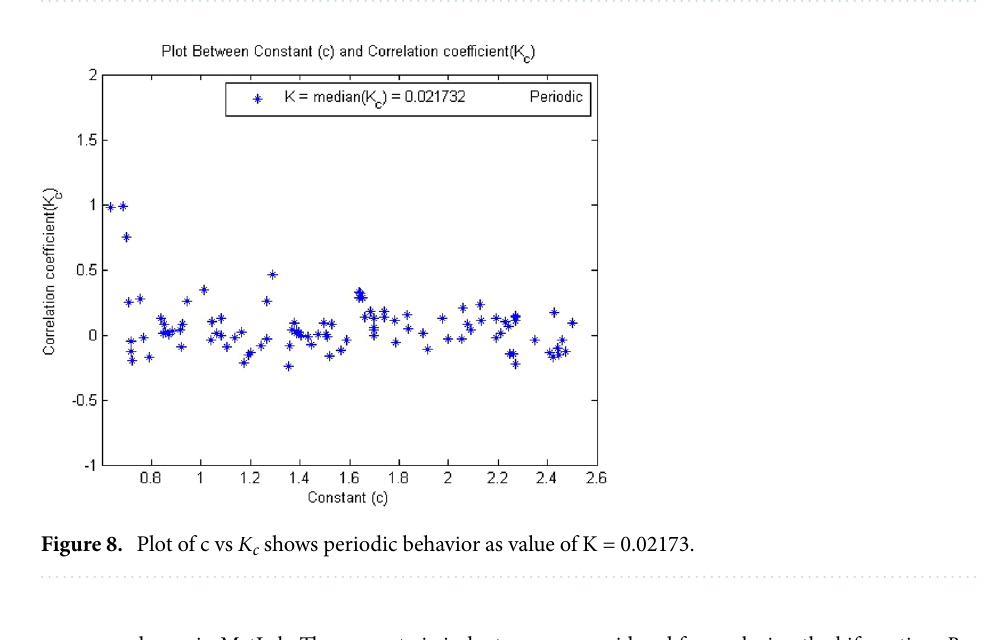
Figure 7. Plot p vs q showed bounded shaped hence its is periodic.